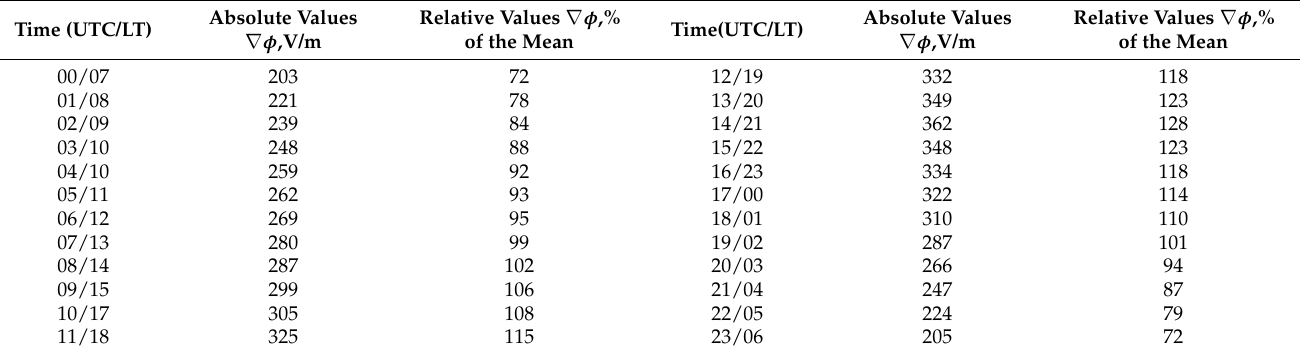
Table A4. Hourly average values of the potential gradient under fair-weather conditions in Tomsk according to data from the IMCES GO for